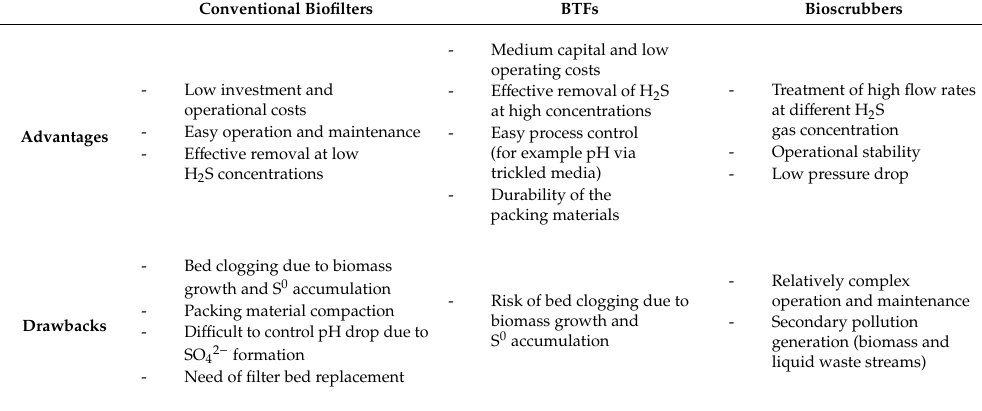
Table 3. Main advantages and drawbacks of biofiltration technologies used for H 2 S